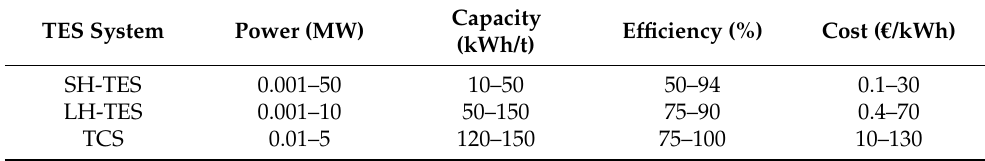
Table 2. Typical characteristics of TES systems [32].